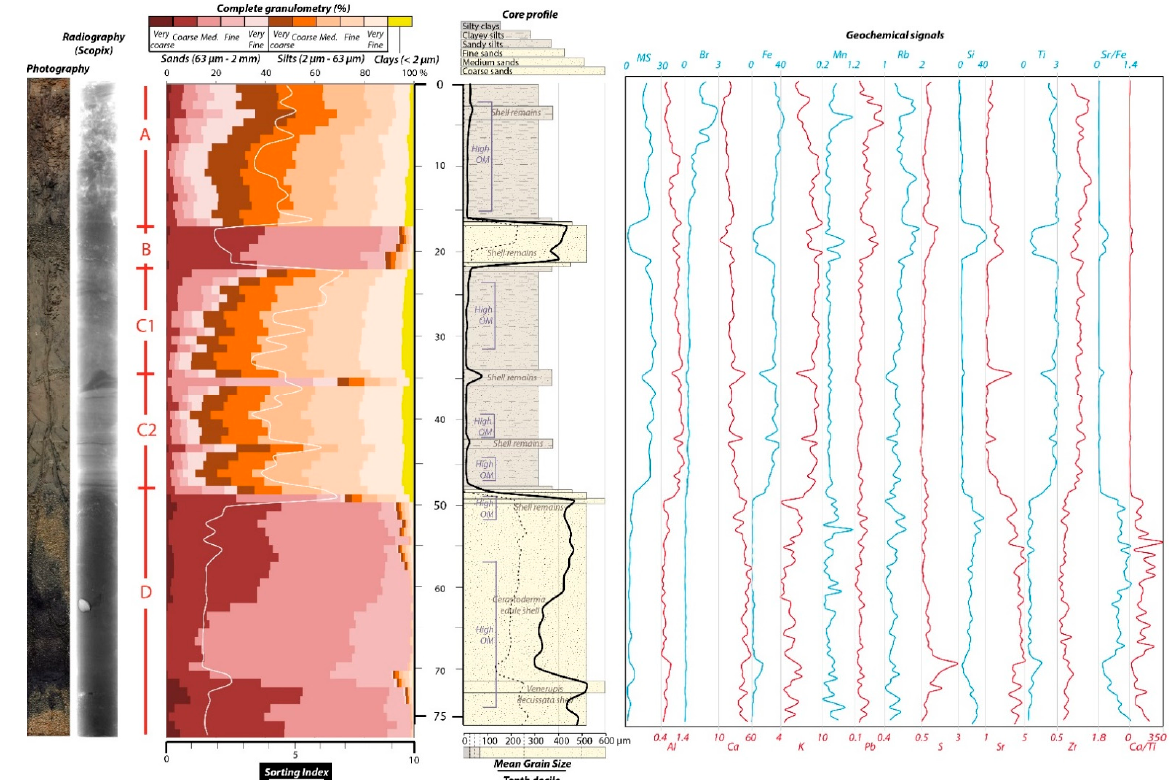
Figure 4. BH-C core log with photography, radiography, grain size results, and geochemical sig- nals.